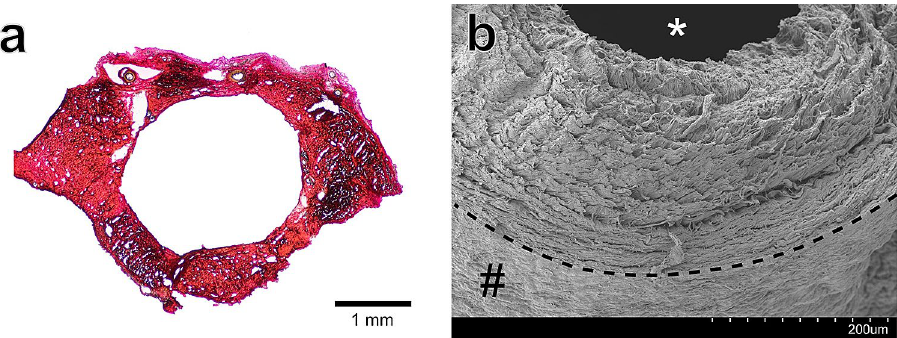
Figure 6. Structural images of the transverse sinus ( a ) Verhoeff–Van Gieson stained sample. ( b ) The cross- section of the dural sinus wall with the lumen (*) and arachnoid surface (#) highlighted. Distinct layers appear to constitute the wall of the dural sinus tissue.